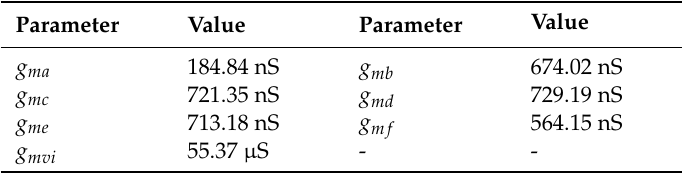
Table 9. Values of transcoductance for the skin model of Figure